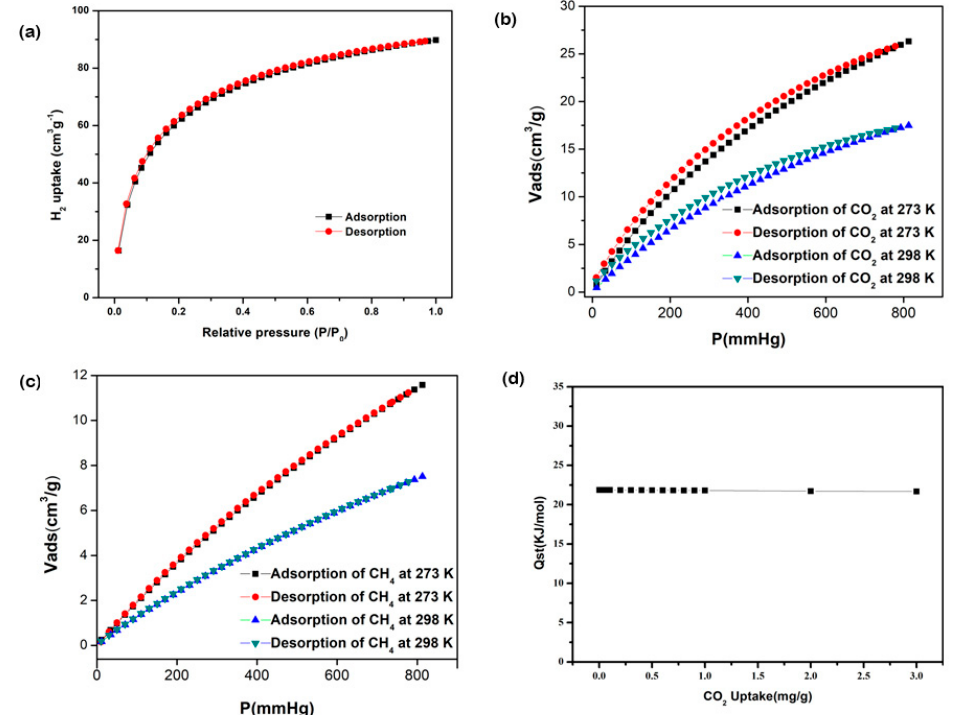
Figure 7. Gas uptakes for complex 1 . ( a ) The H 2 adsorption capacity for complex 1 at 77 K; ( b ) The CO 2 adsorption capacity for complex 1 at 273 and 298 K; ( c ) The CO 2 adsorption capacity for complex 1 at 273 K and 298 K; ( d ) The Q st of complex 1 for CO 2 .